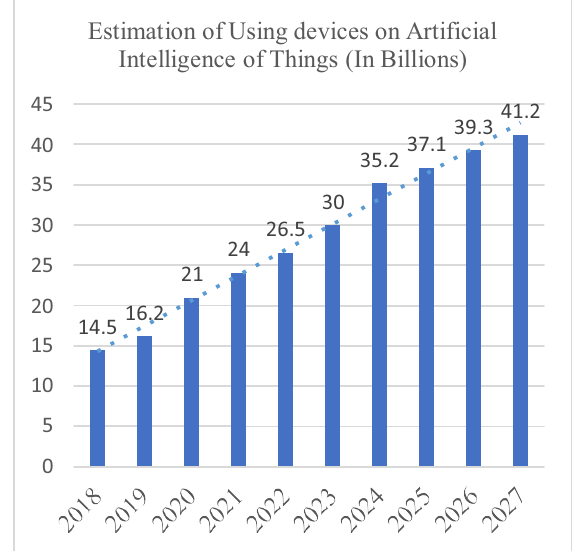
Fig. 3. Estimation of IoT devices integrated in Artificial Intelligence of Things technologies. [18] With Calculation of compound annual growth